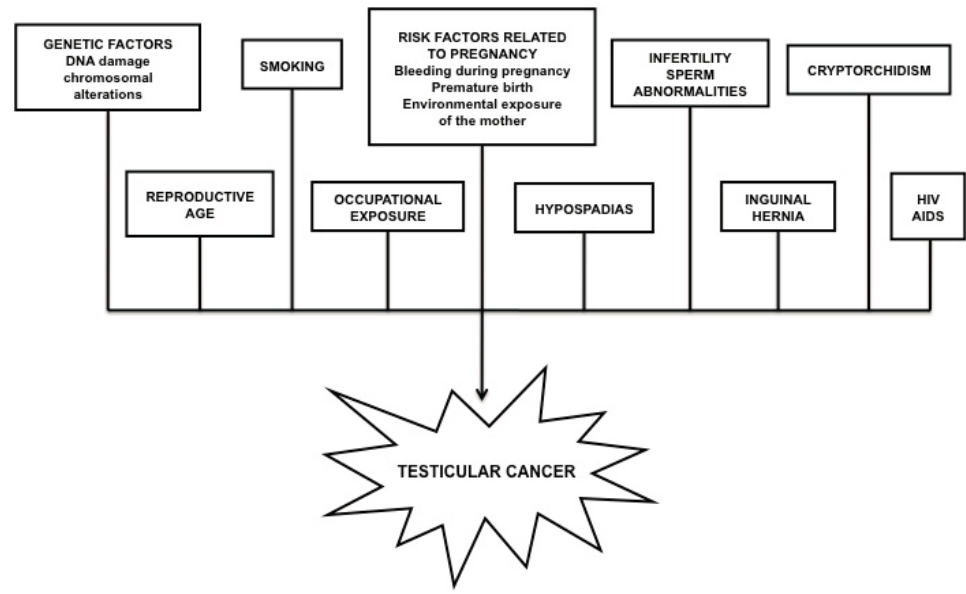
Figure 1. The most common risk factors contributing to testicular cancer